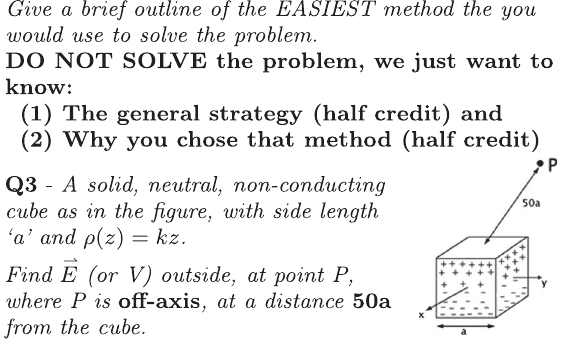
FIG. 1. A sample item from the original FR CUE. Question prompt has been paraphrased; see Ref. [40] for full question prompt, rubric, and scoring